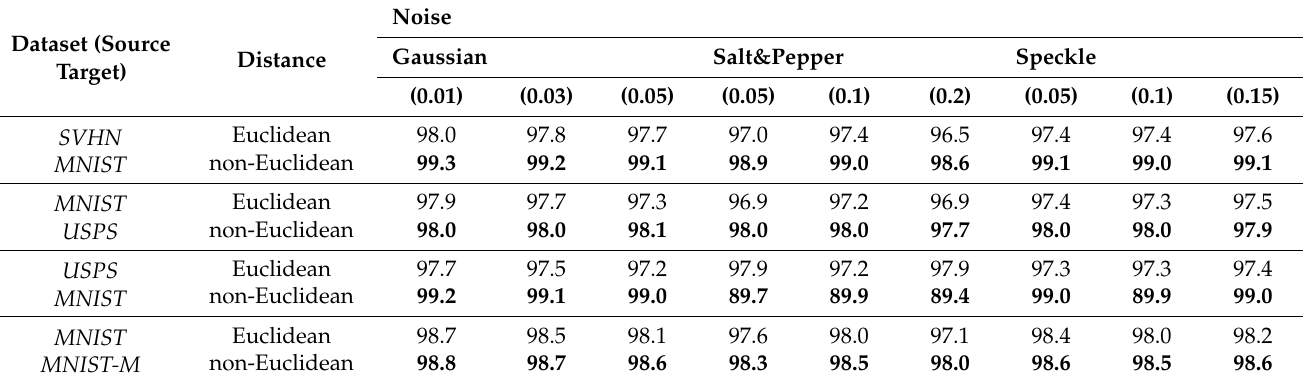
Table 3. Performance of proposed method (accuracy) with different kinds of